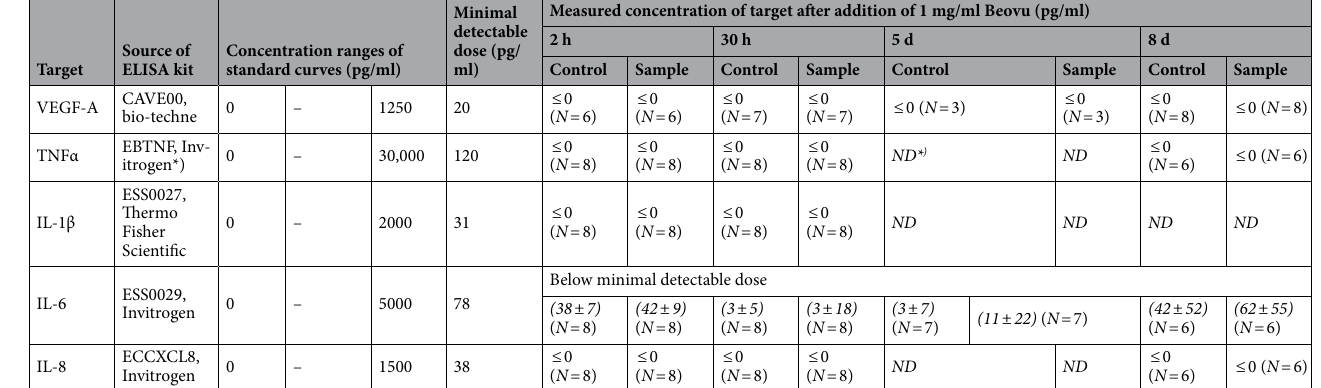
(Fig. 1c, left panel), induced a slight, but significant transient decline of cell index values early after addition to the cultivated iBREC, followed by a more pronounced and sustained lowering effect, becoming evident about 1.5 days later (Fig. 1b, right panel). The extend of the Beovu-induced disturbance varied, often but not always depending on the lot of the pharmaceutical formulation. In contrast, cell index values of Lucentis-treated iBREC remained stable, reflecting those of control cells (Fig. 1c, right panel). Blocking VEGF-A 165 -induced signaling through specific inhibition of the VEGFR2 with 10 nM nintedanib (Fig. 1d, upper panel) or with 10 nM tivoza- nib (Fig. 1e) also did not lead to similarly low cell index values during prolonged exposure; interestingly, even slightly higher cell index values were observed with 10 nM nintedanib. Treatment of the cells with the very high concentration of 100 nM nintedanib did not change the cell index at all (Fig. 1d, lower panel). Beovu did not induce cellular stress or an inflammatory response. The concentrations of cytokines expressed by microvascular EC and associated with disturbance of their barrier (i.e. VEGF-A, interleukin (IL)-8 or TNFα), cellular stress (i.e. IL-6), or with an inflammatory response (i.e. IL-1β) in cell culture supernatants of iBREC treated with Beovu for two hours ( → early decline of the cell index) or thirty hours ( → persistently lowered cell index values) were measured, but their concentrations were always below the minimal amounts detectable by the ELISAs used (Table 1). Even after prolonged exposure for several days, the cells did not secrete IL-6, IL-8, TNFα or VEGF-A (Table 1).